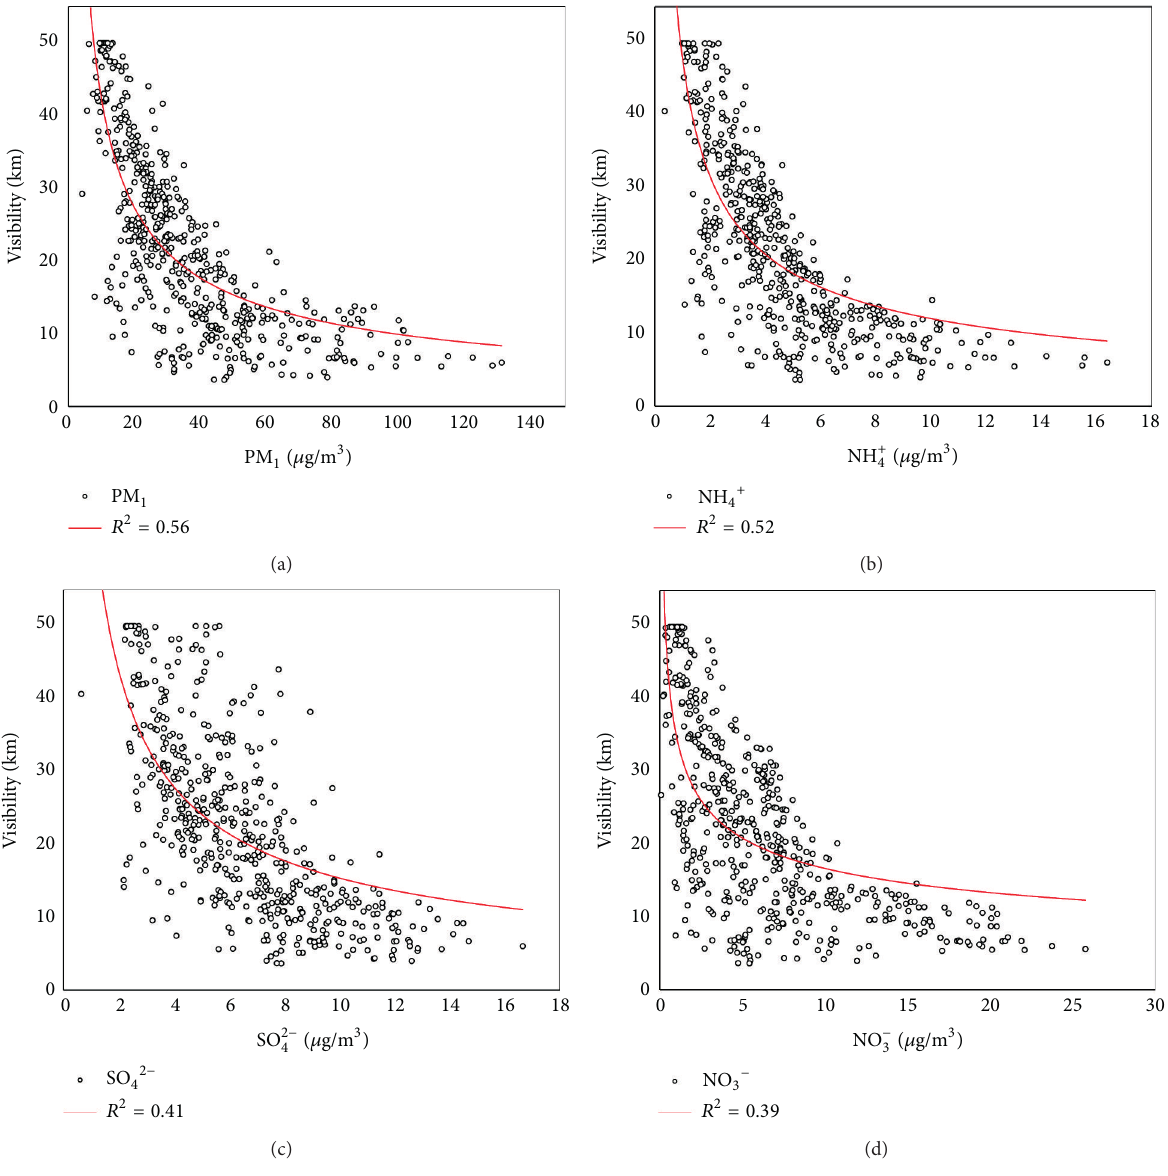
Figure 3: The relationship of particulate species concentration ( 𝜇 g/m 3 ) and visibility (km) (a) PM 1 , (b) NH 4+ , (c) SO 42− , and (d) NO 3− . Data for rain periods and RH > 90% are left out. Data where vis. > 50 km. (upper limit of the instrument) are shown but not used in the 𝑅 2